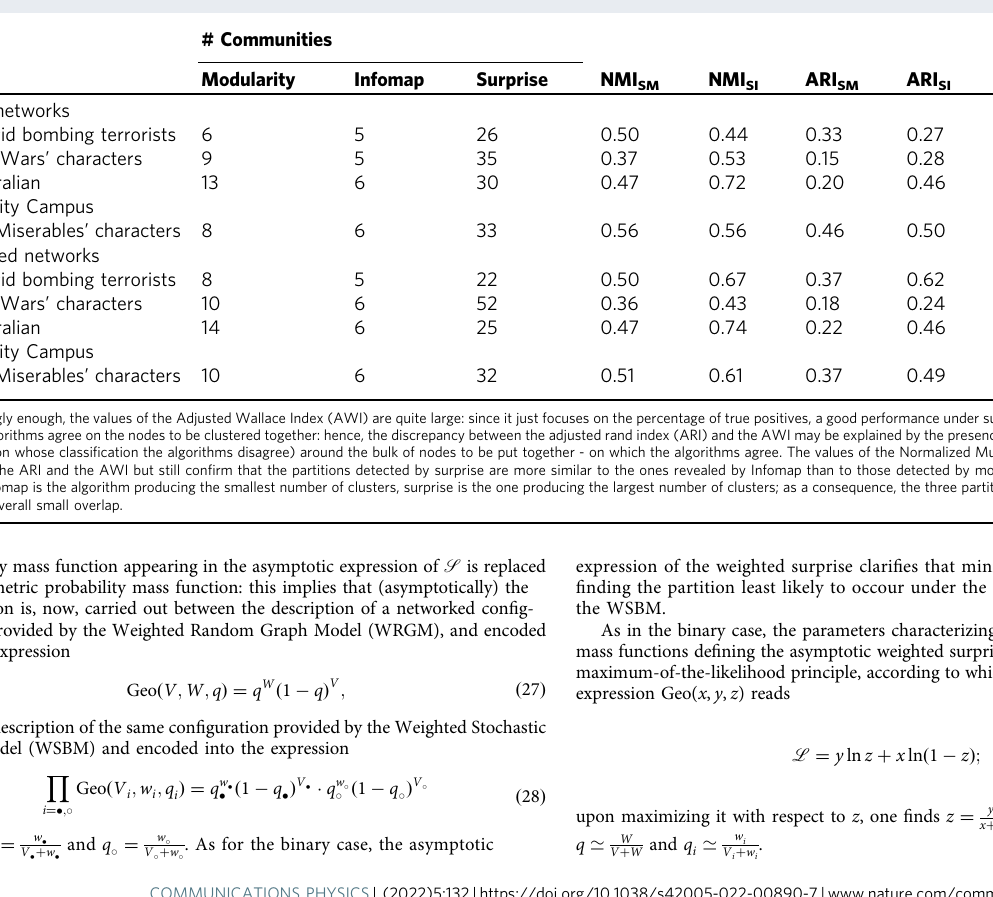
Table 2 Table comparing the performance of modularity, Infomap and surprise on the real-world networks considered in the present